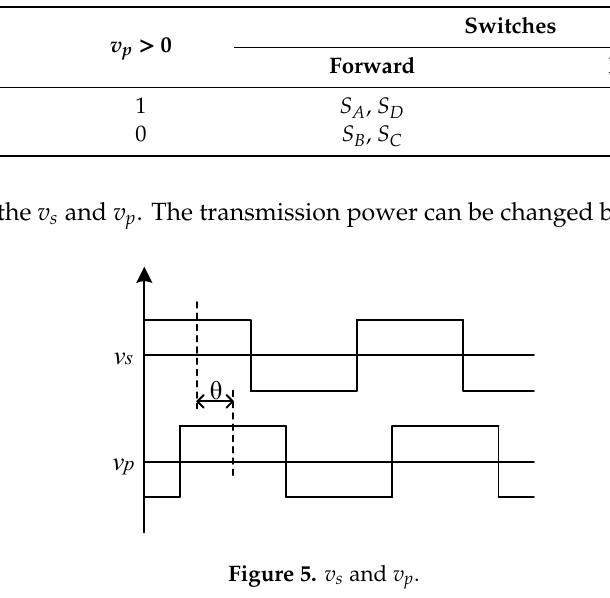
Figure 5. v s and v p .